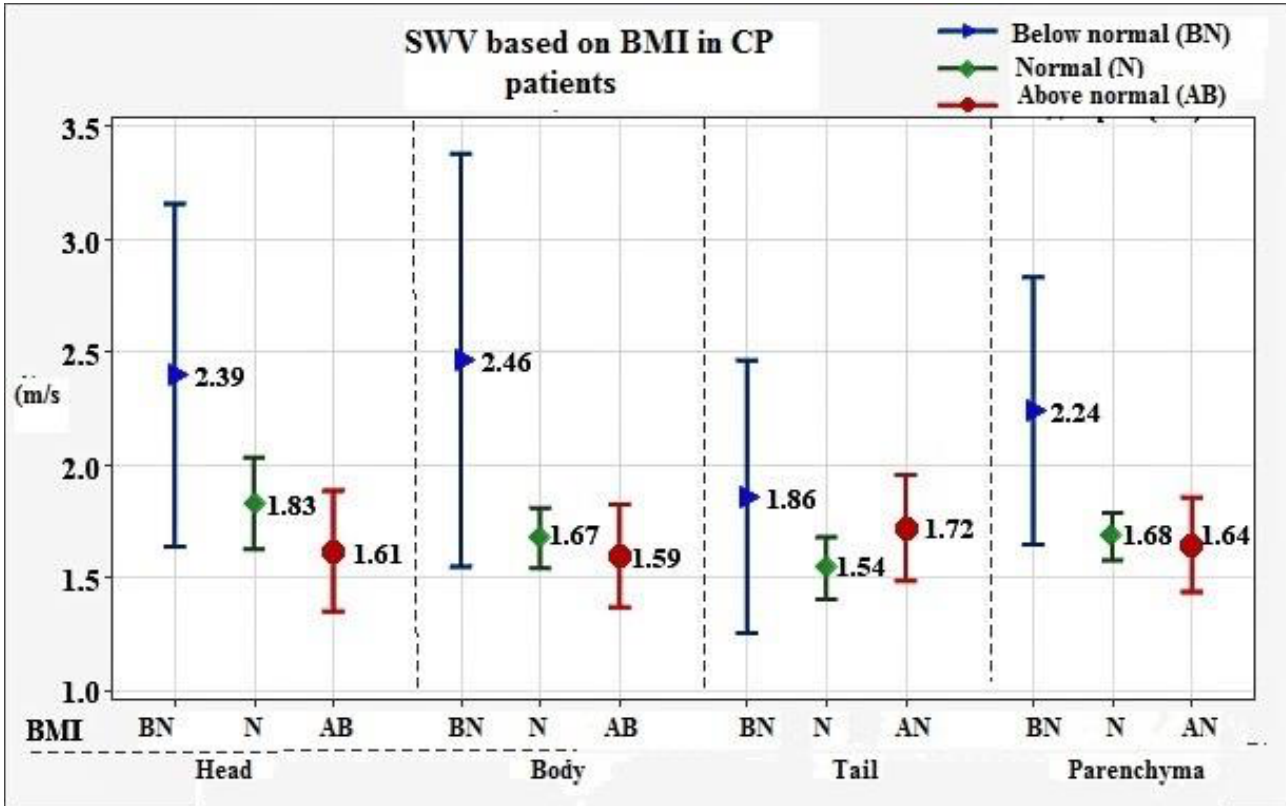
Figure 2. Association between BMI and SWV in CP patients.